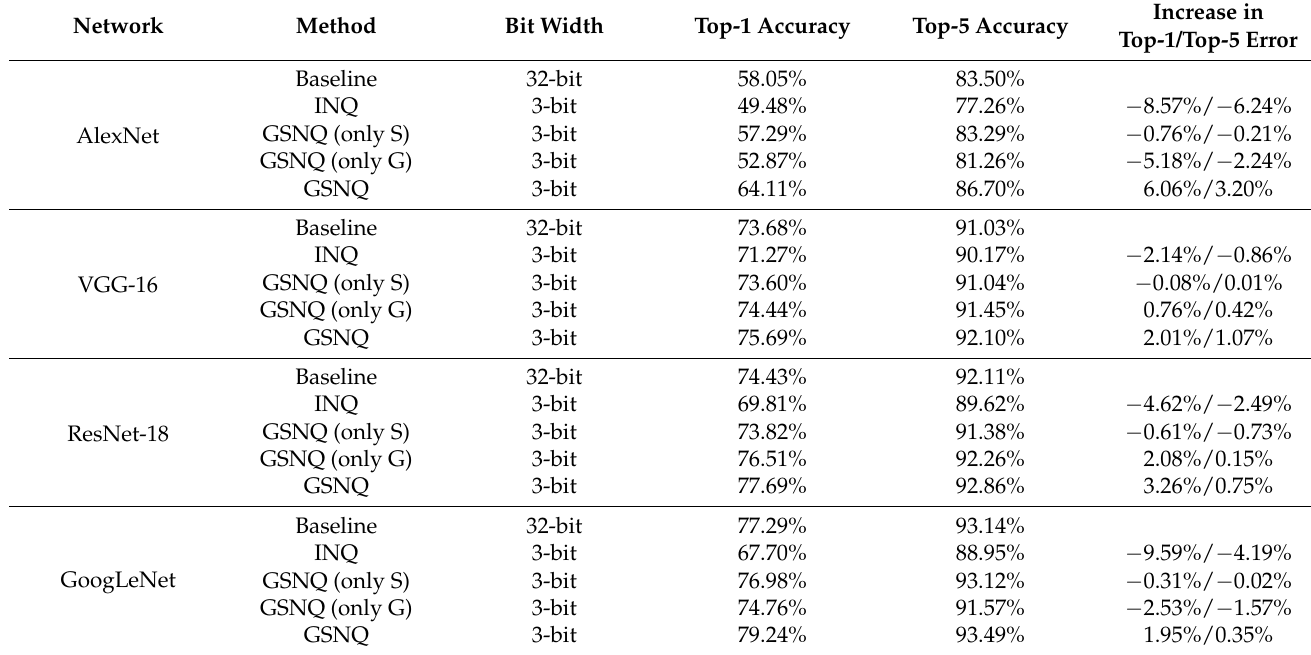
Table 8. Ablation experiments on 3-bit quantization on the Mini-ImageNet